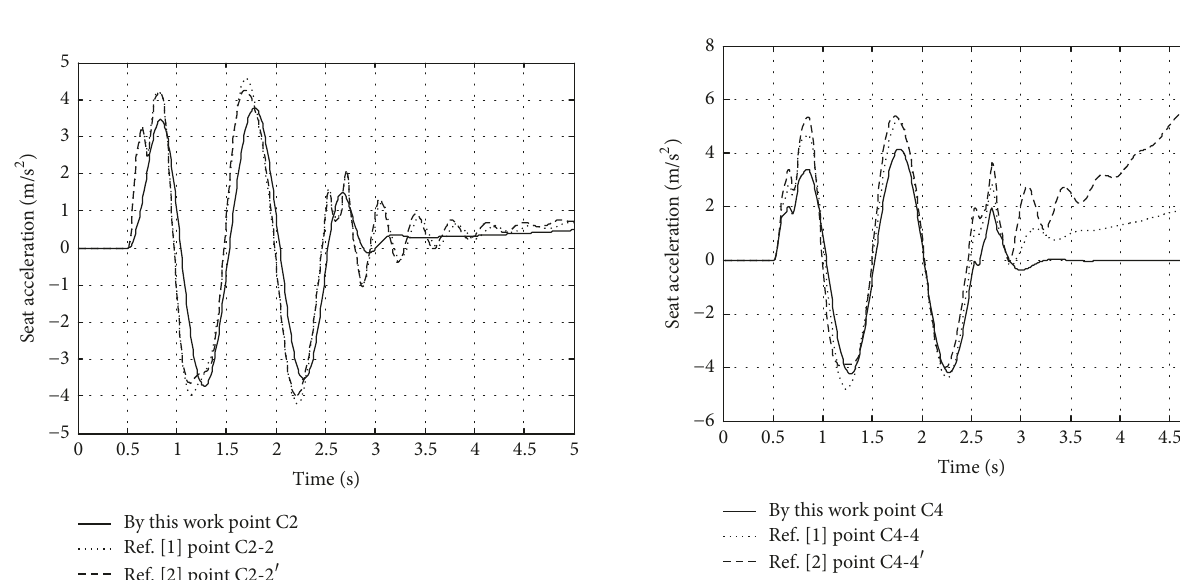
Figure 19: Time response of seat acceleration of design points C3, C3 3, and C3 3 󸀠 .